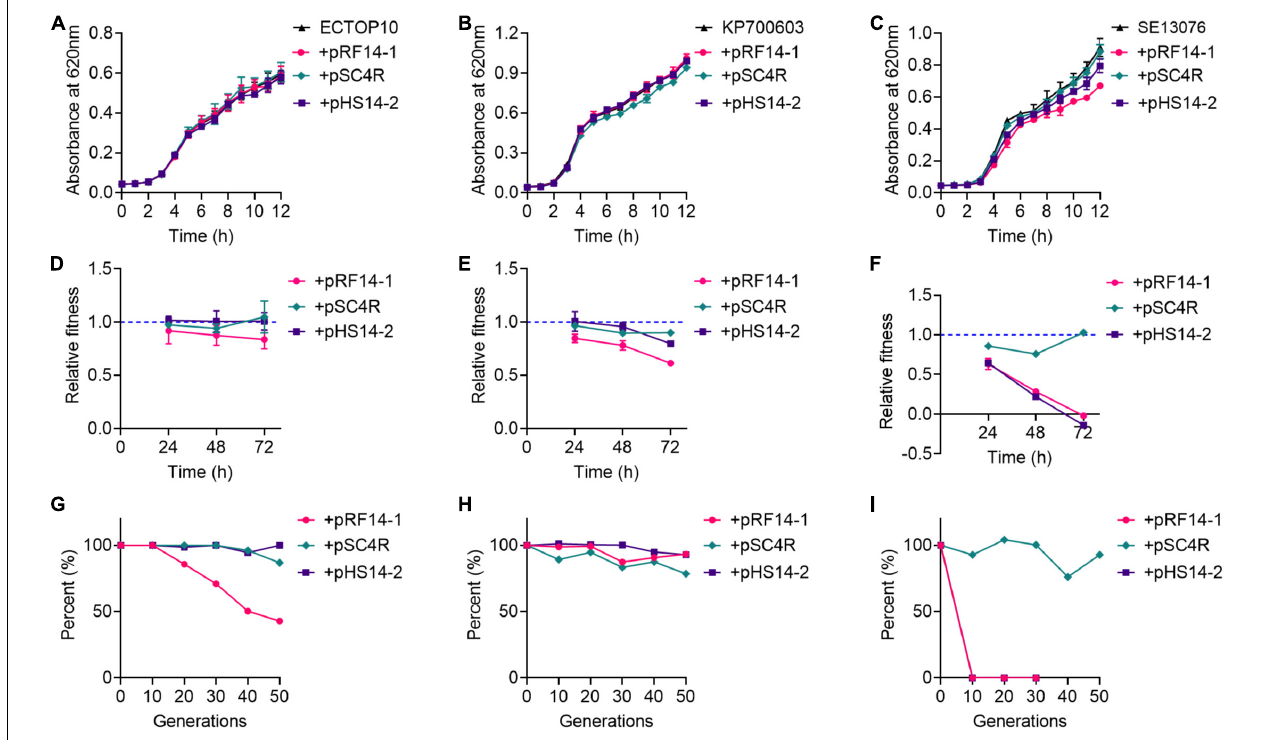
FIGURE 2 | tet (X4)-positive IncX1 plasmids encoding H-NS protein displays low fitness cost in host bacteria. (A–C) Growth curves of transformants with E. coli TOP10 (A) , K. pneumoniae ATCC700603 (B) , or S. Enteritidis ATCC13076 (C) as recipient strains. (D–F) Relative fitness of transformants with E. coli TOP10 (D) , K. pneumoniae ATCC 700603 (E) , or S. Enteritidis ATCC13076 (F) as recipient strains at 24, 48, and 72 h. (G–I) Plasmid stability in three recipient strains, including E. coli TOP10 (G) , K. pneumonia e ATCC700603 (H) , or S. Enteritidis ATCC13076 (I) . Data are representative of three biological replicates and shown as mean ±